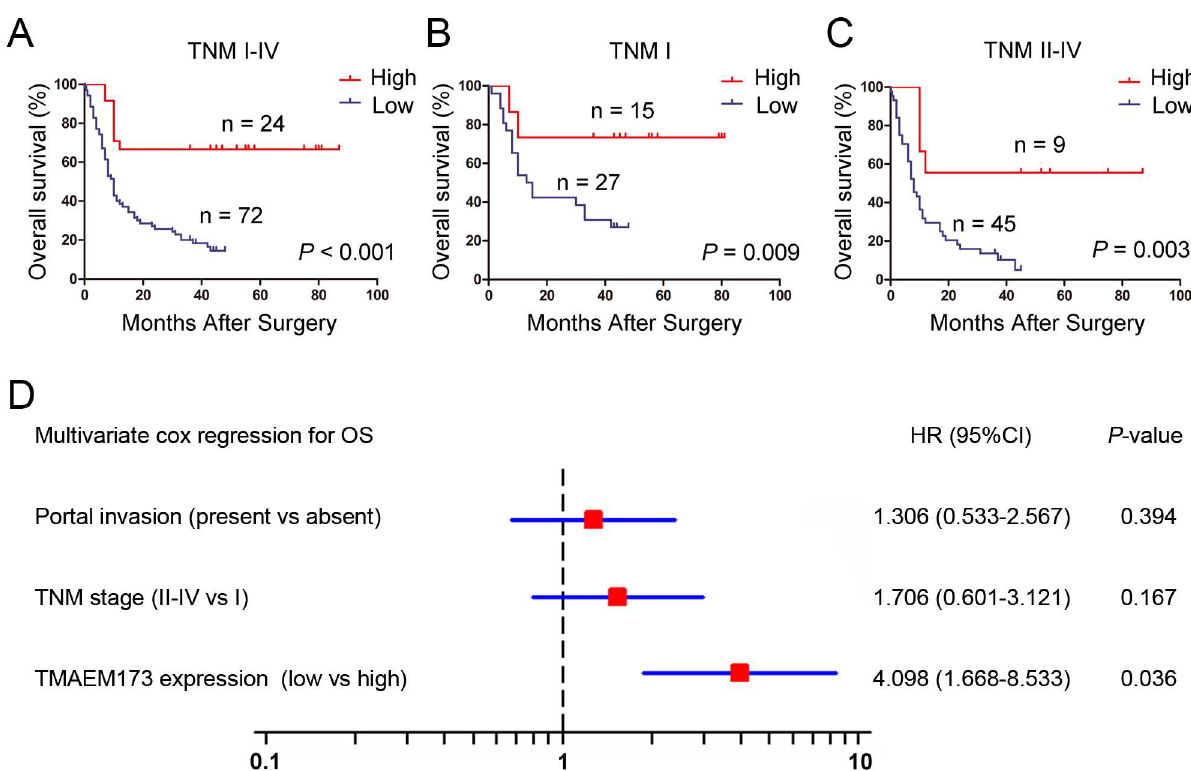
Fig 2. The predictive value of TMEM173 expression in patients with HCC. (A-C) Kaplan-Meier survival analysisshowingthe relationshipbetween TMEM173 expression and overall survival in all patients (A), patients at TNM I stage (B) and patients at TNM II-IV stage (C). (D) Cox multivariate analysis identifiedthe independent prognostic factors for overall survival for patients with HCC.